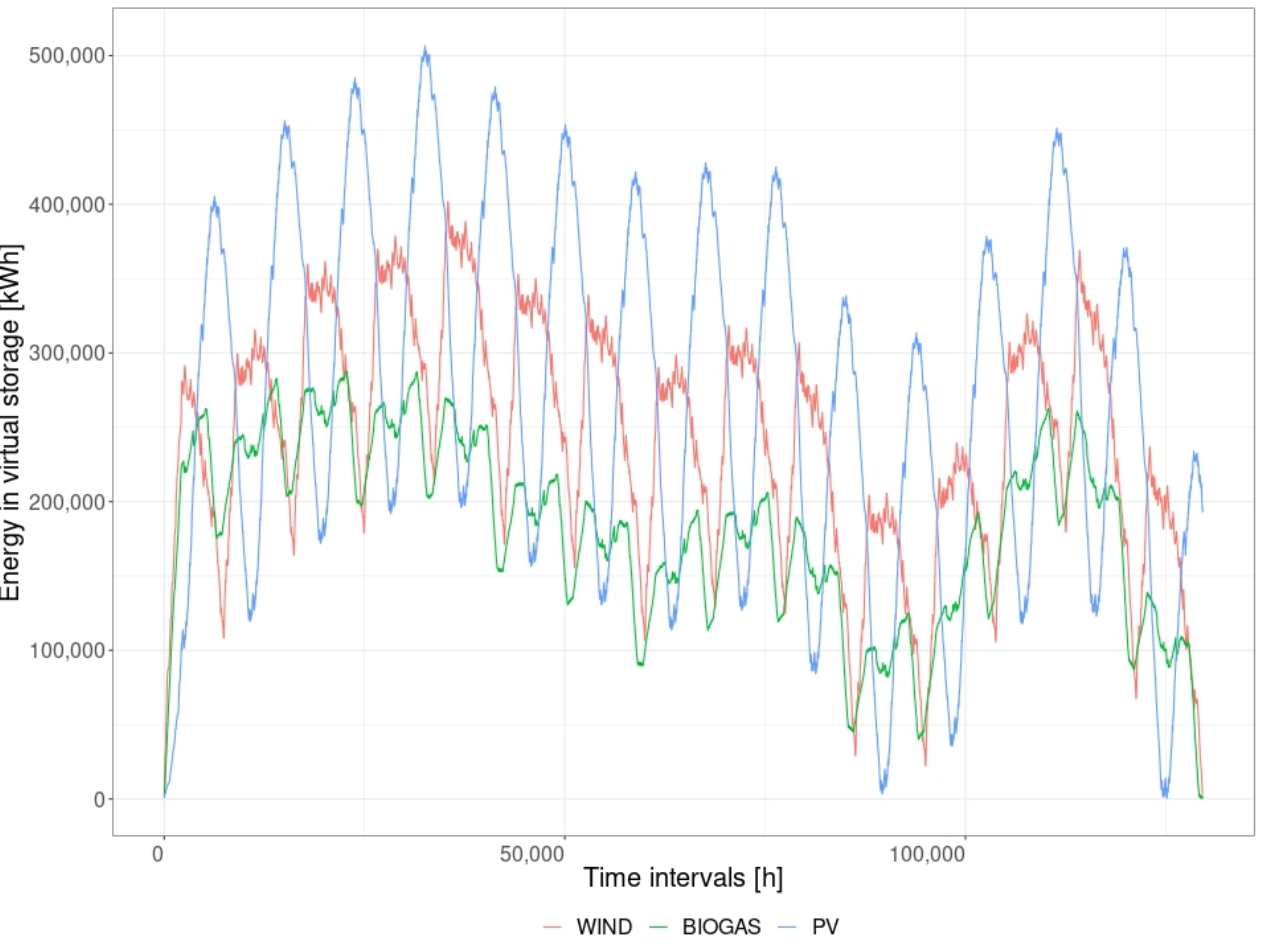
Figure 3. Typical rate of filling of the network energy deposit based on the generation technology.